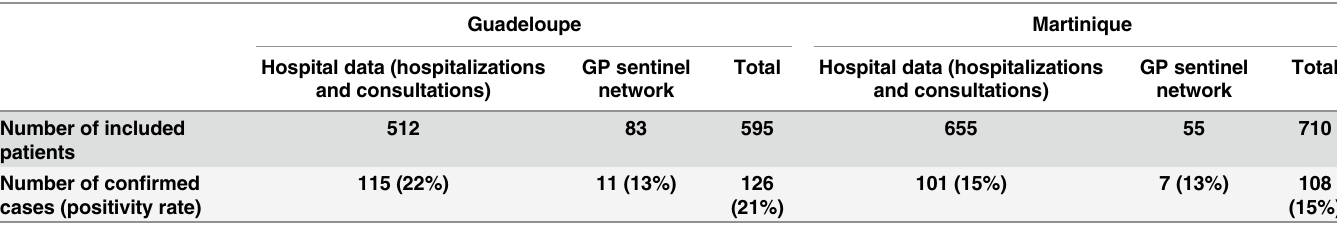
Table 1. Number of included patients and results of leptospirosis diagnosis in Guadeloupe and Martinique,